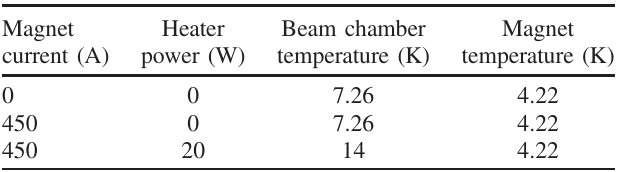
TABLE III. Observed temperatures of the beam chamber and the magnet during beam heat load simulation test.